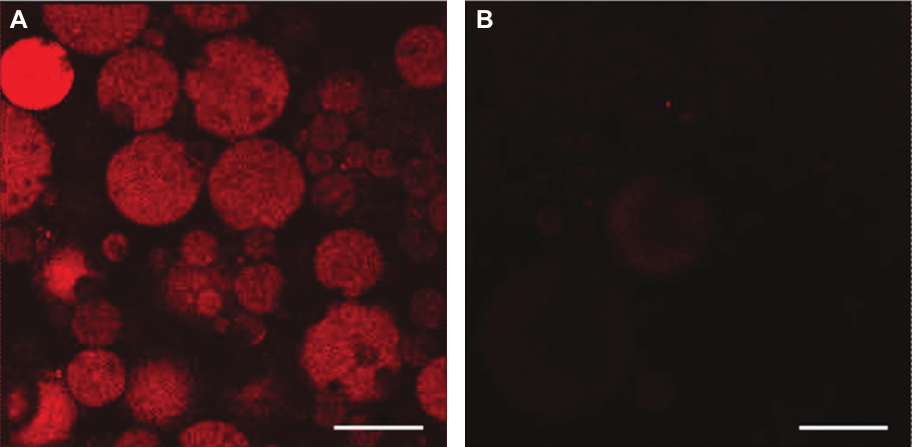
Figure 19 Visualized microdroplets before (A) and after (B) the repair-and-go experiment characterized by fluorescence confocal micro- scopy. Scale bar, 150 μ m (reprinted with permission from [91]). Copyright 2012, Macmillan Publisher Ltd: Nature